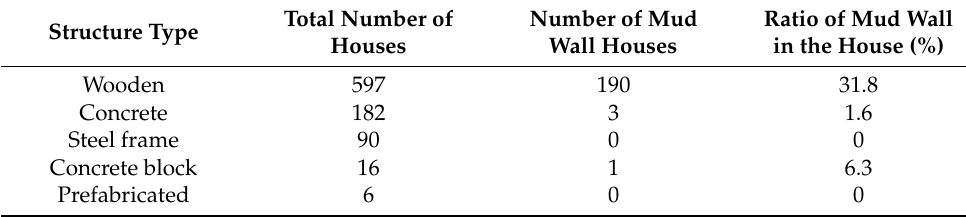
Table 3. Ratio of mud wall in each structure type.